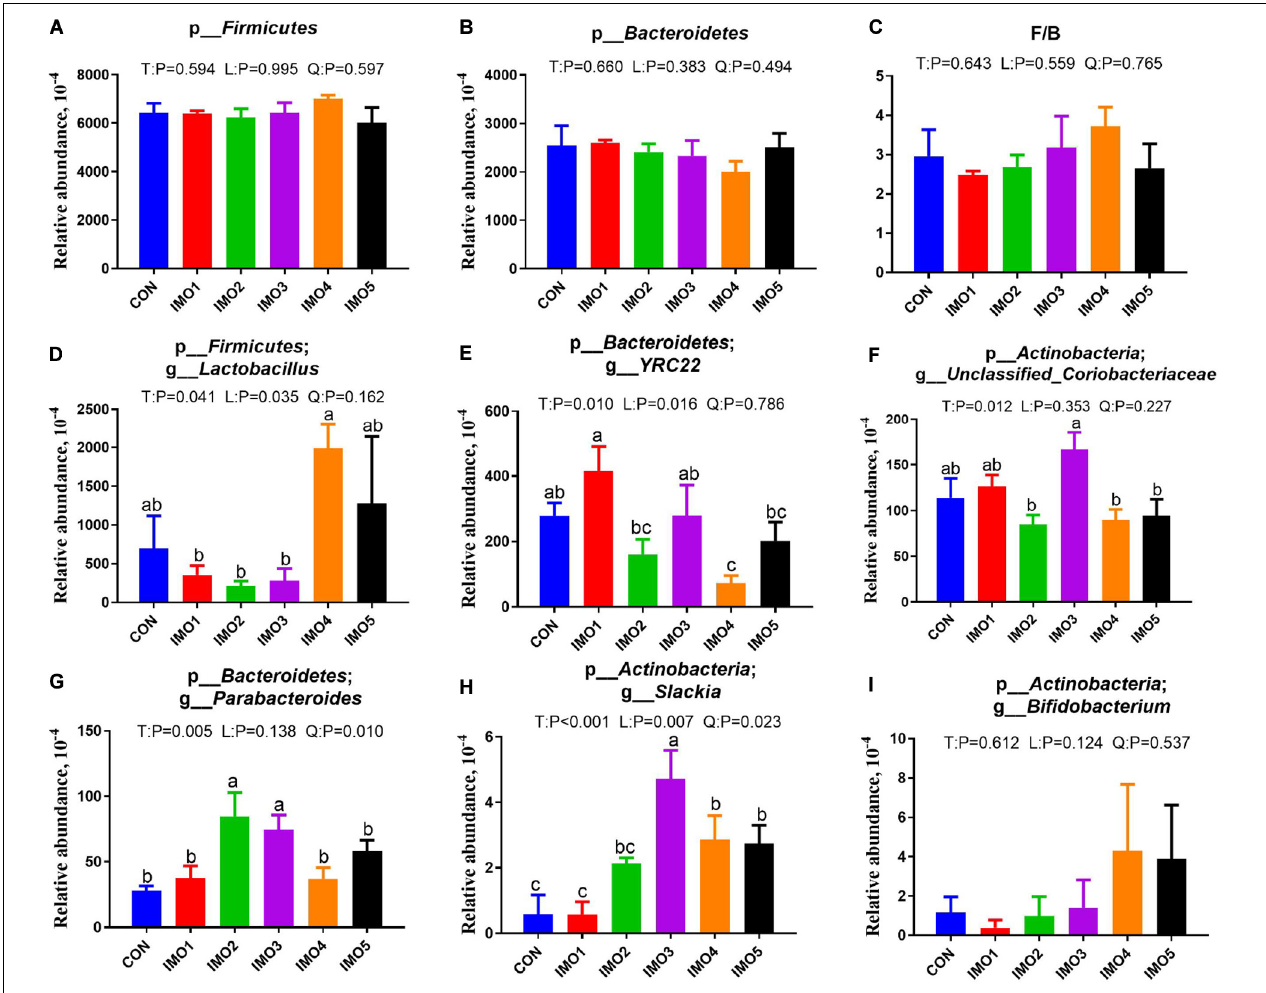
FIGURE 6 | Effects of dietary isomaltooligosaccharide (IMO) levels on the gut microbiota compositions at the phylum level in sows. (A) p_ Firmicutes , (B) p_ Bacteroidetes , (C) F/B, Firmicutes / Bacteroidetes , (D) p_ Firmicutes ; g_ Lactobacillus , (E) p_ Bacteroidetes ;g_ YRC22 , (F) p_ Actinobacteria ; g_ Unclassified_Coriobacteriaceae , (G) p_ Bacteroidetes ; g_ Parabacteroides , (H) p_ Actinobacteria ; g_ Slackia , (I) p_ Actinobacteria ; g_ Bifidobacterium . Data are presented as means ± SEM ( n = 5). (a–c) Significant effect of treatment ( P < 0.05; values with different lowercase letters are significantly different; T, total; L, linear; Q,